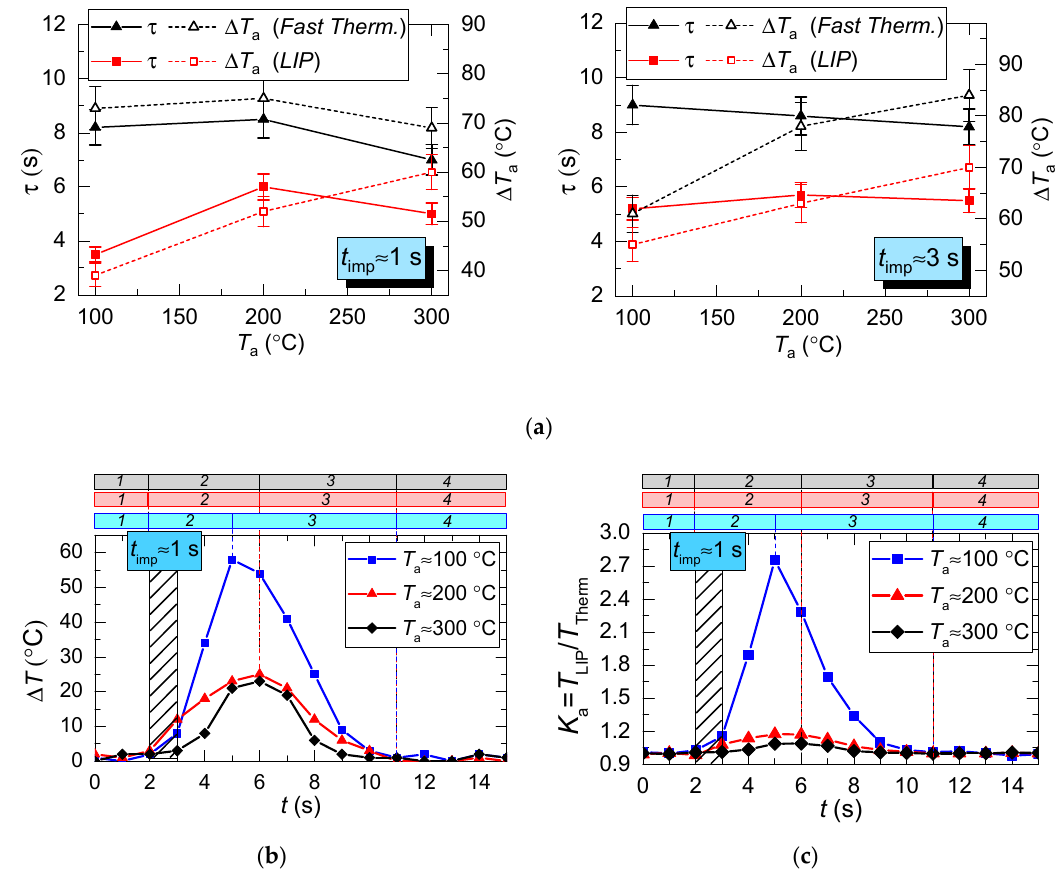
Figure 6. Parameters τ and Δ T a of heated air calculated for two measurement types ( a ); an example of instantaneous deviation ( Δ T ) of LIP measurement from thermocouple (Fast Therm.) measurement ( b ); coefficient K a ( c ), areas per time period: 1 : prior to droplet injection; 2 : T a temperature drop to the lowest value; 3 : T a temperature growth; 4 : T a temperature recovery.